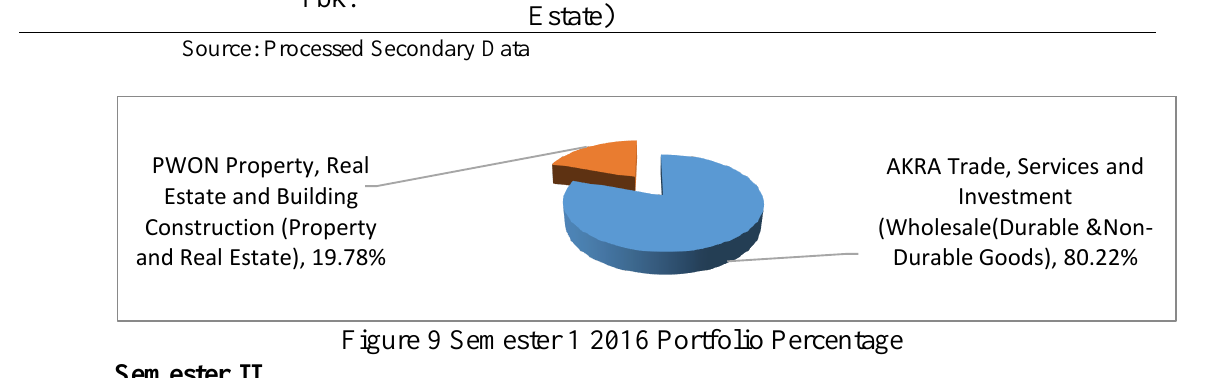
Figure 9 Semester 1 2016 Portfolio